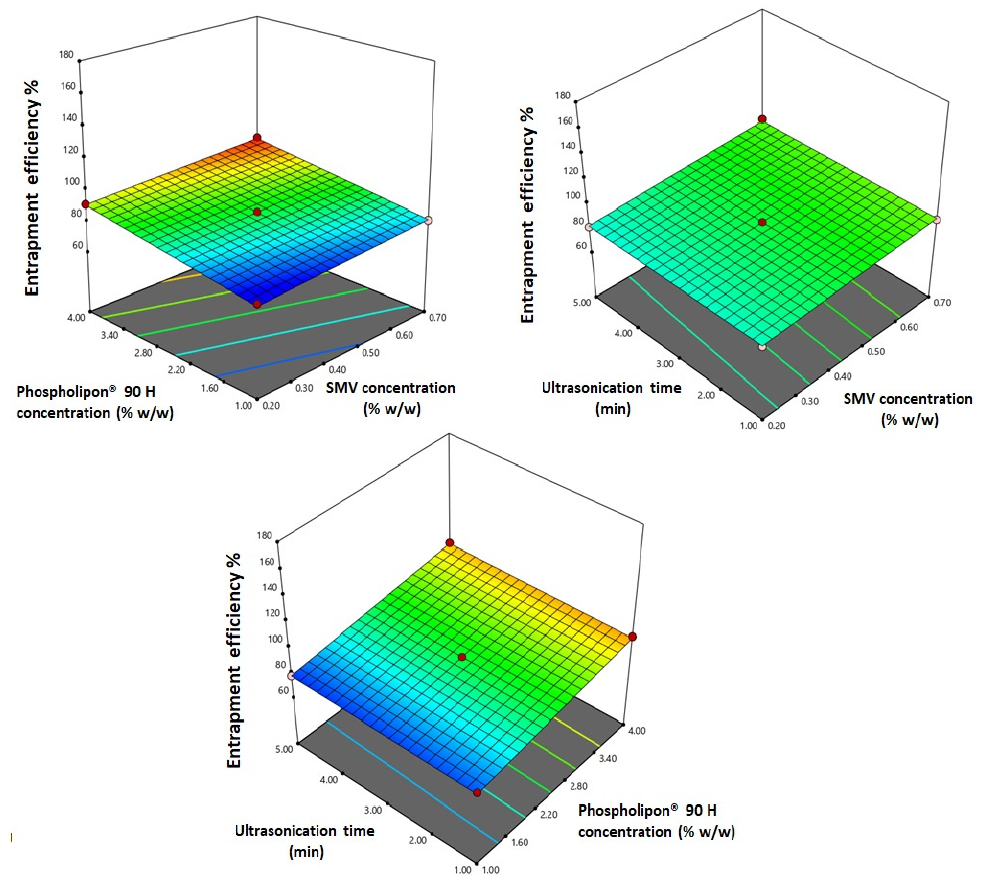
Figure 3. Response 3D-plots for the effect of SMV concentration (X 1 ), Phospholipon ® 90 H (X 2 ), and ultrasonication time (X 3 ) on the entrapment efficiency of SMV-EMLs.